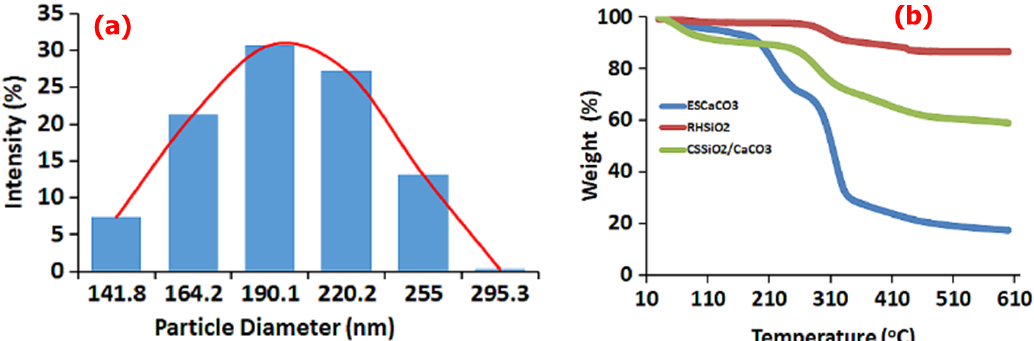
Figure 2. ( a ) DLS of CS-SiO 2 /CaCO 3 NCs and ( b ) TGA analysis of ESCaCO 3 NPs, RHSiO 2 NPs, and CS-SiO 2 /CaCO 3 NCs.